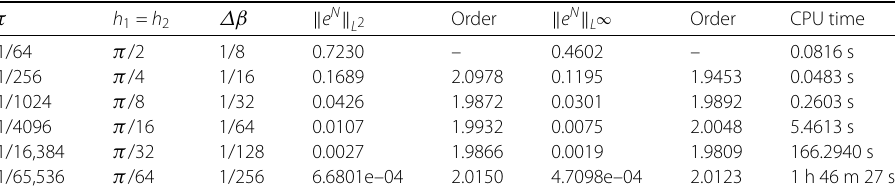
Table 3 Errors and convergence orders of scheme (43)–(44) with an optimal step size ratio for τ , h 1 , h 2 and Δβ (Example 1)